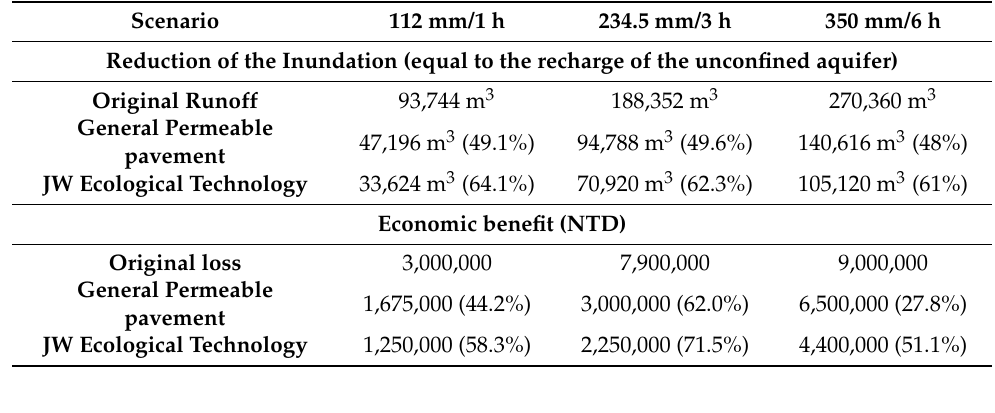
Table 7. Comparisons of multi-targets.